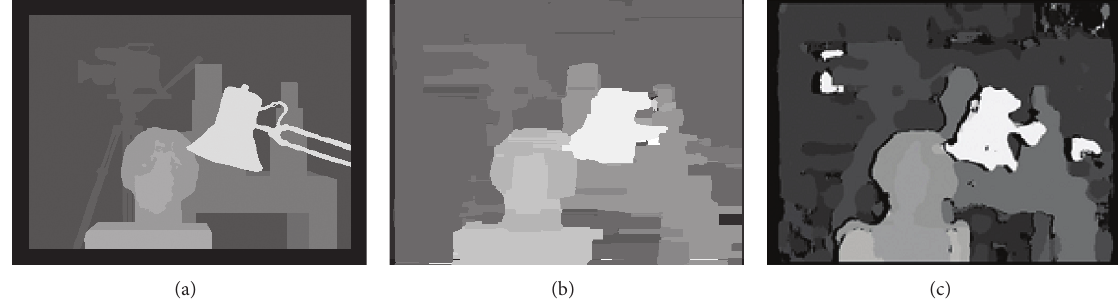
Figure 10: Disparity ground truth (a) and results from the profile shape matching (b) and census implementation by Jin et al. (c) of the Tsukuba stereo image